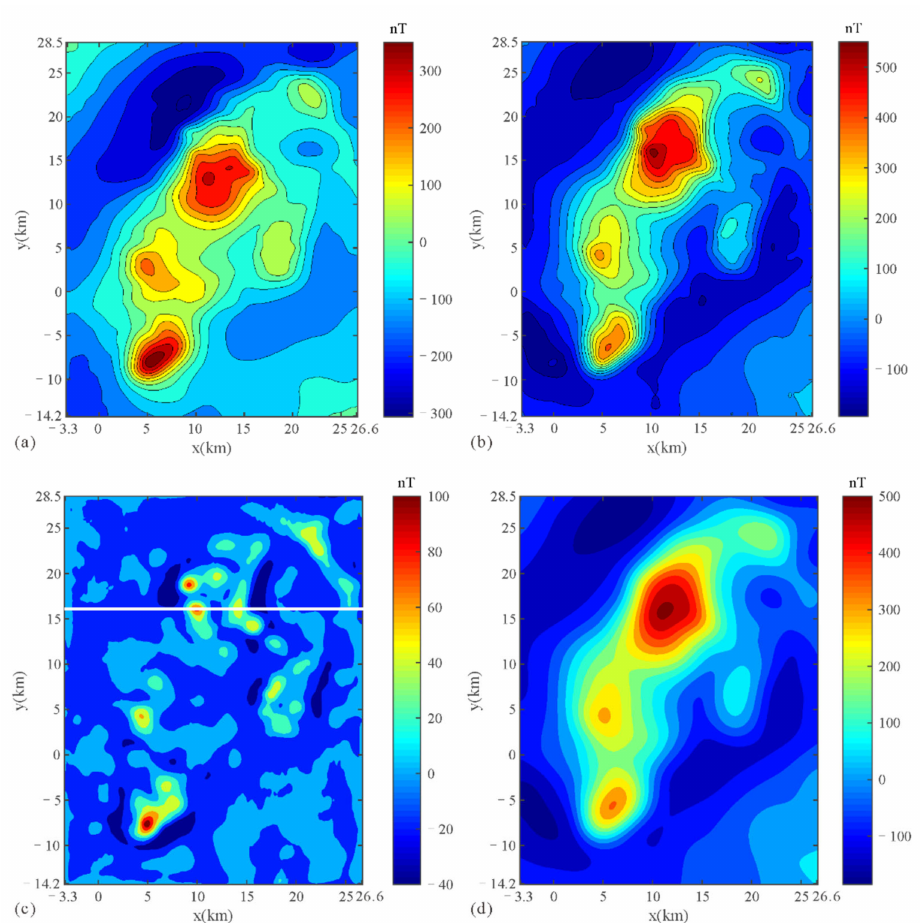
Figure 8. Measured aeromagnetic data of Qihe area: ( a ) measured total magnetization intensity data ∆ T ; ( b ) magnetic reduction to the pole (RTP) data; ( c ) the magnetite-caused data extracted from RTP data by high-pass filtering; ( d ) the regional data removed from RTP data by high-pass